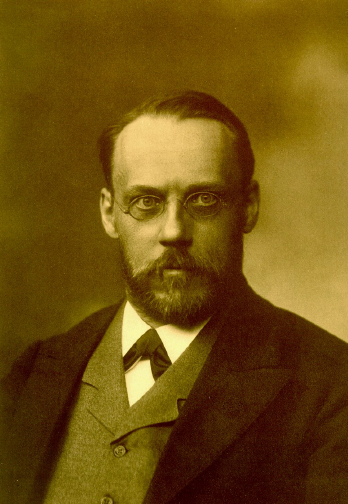
Figure 12. Adolf Schmidt’s portrait. Source: Helmholtz Centre Potsdam – GFZ.